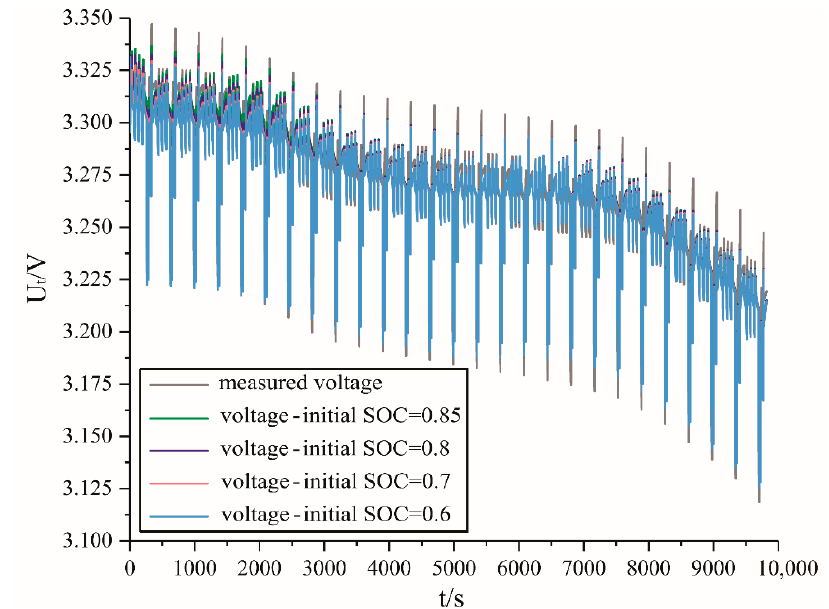
Figure 23. Comparison of terminal voltage filtered by FEKF in different SOC initial errors under 26 continuous DST conditions at 28 °C.